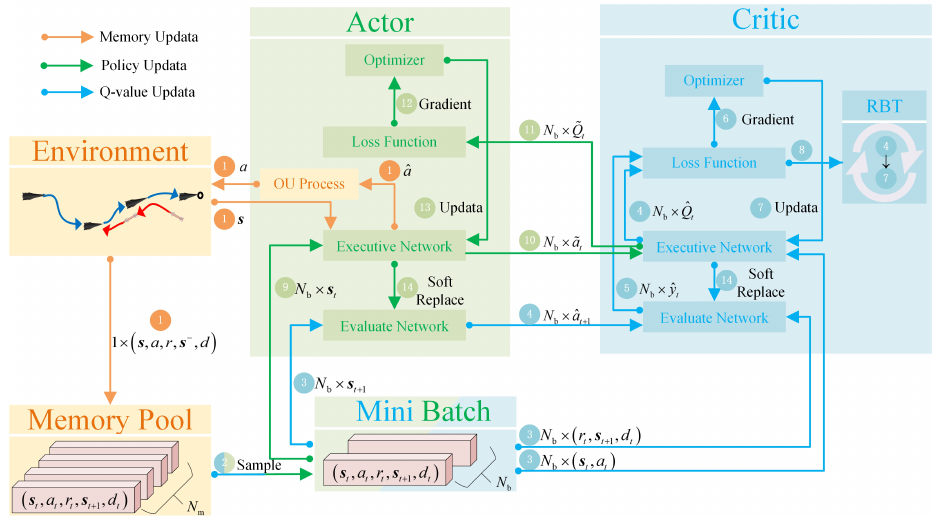
Figure 2. Signal flow of the RBT-DDPG algorithm. When a sample batch is used to update the CN parameters, the CN is repetitively trained using the loss function as its reference threshold (as shown in Steps 4–7 of the Figure), thereby avoiding a serious misestimate of